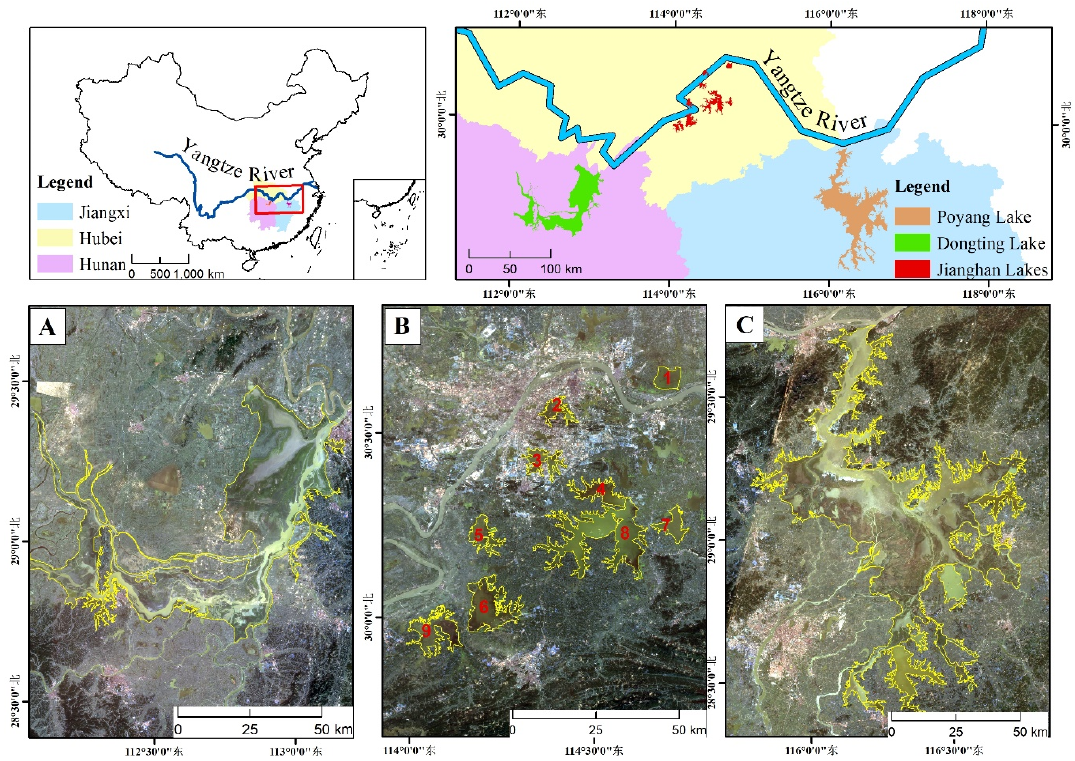
Figure 1. Location of the study area: ( A ). Dongting Lake (DT). ( B ). Jianghan Lakes (JH), which consists of (1) Zhangdu Lake; (2) Dong Lake; (3) Tangxun Lake; (4) Niushan Lake; (5) Lu Lake; (6) Futou Lake; (7) Baoan Lake; (8) Liangzi Lake; and (9) Xiliang Lake. ( C ). Poyang Lake (PY). The satellite image of the study area is the median value of Sentinel-2 in 2018, which uses the color composite of the Sentinel-2 time-series: blue = band 2, green = band 3, and red = band